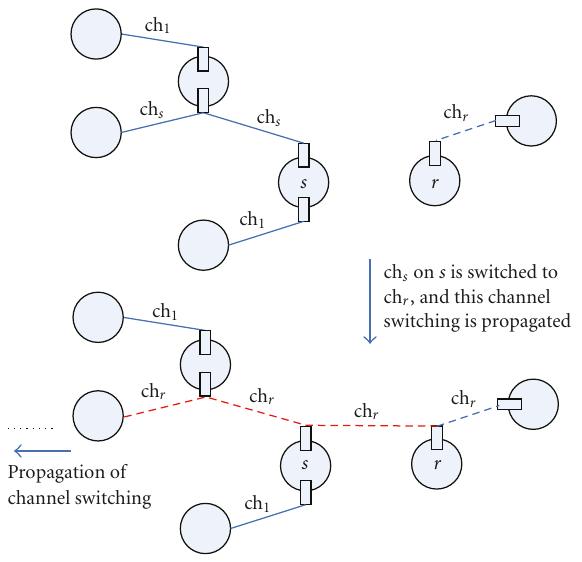
Figure 6: Channel switching and channel switching propagation in flow oriented channel assignment (FOCA) heuristic algorithm.